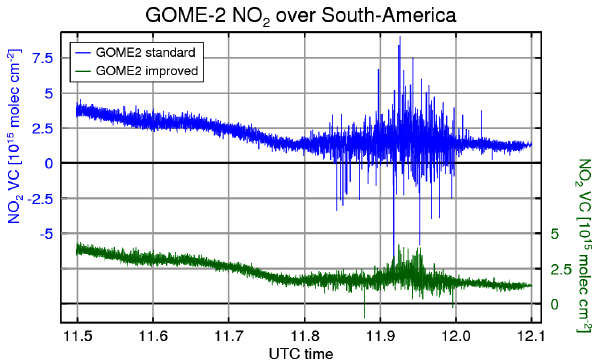
Fig. 10. Example of the difference in effect of the Southern Atlantic Anomaly on an individual orbit. Results from the standard evalua- tion are shown in the upper part of the figure, the improved results in the lower part. The orbit shown is the right orbit in Fig. 3 passing over the eastern part of South America on 1 August